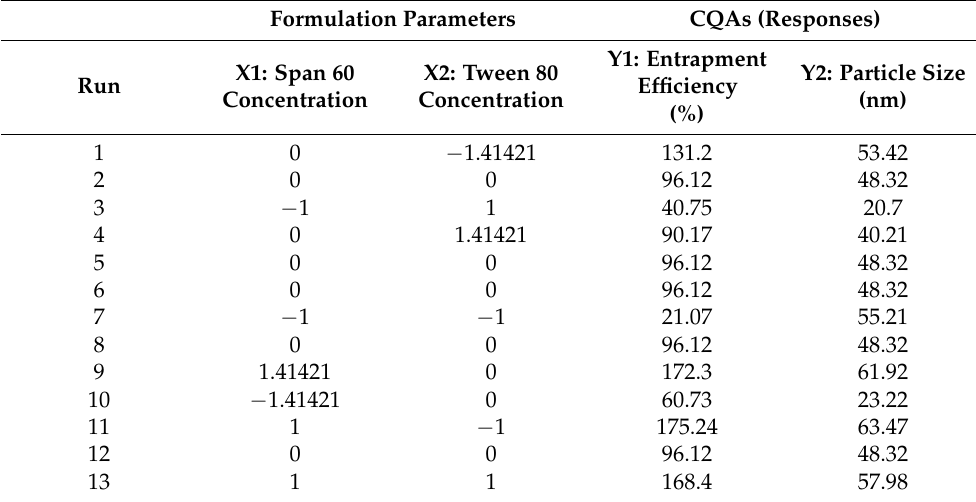
Table 2. Experimental runs, formulation parameters (described in coded levels) and critical quality attributes (CQAs) of zolmitriptan-loaded